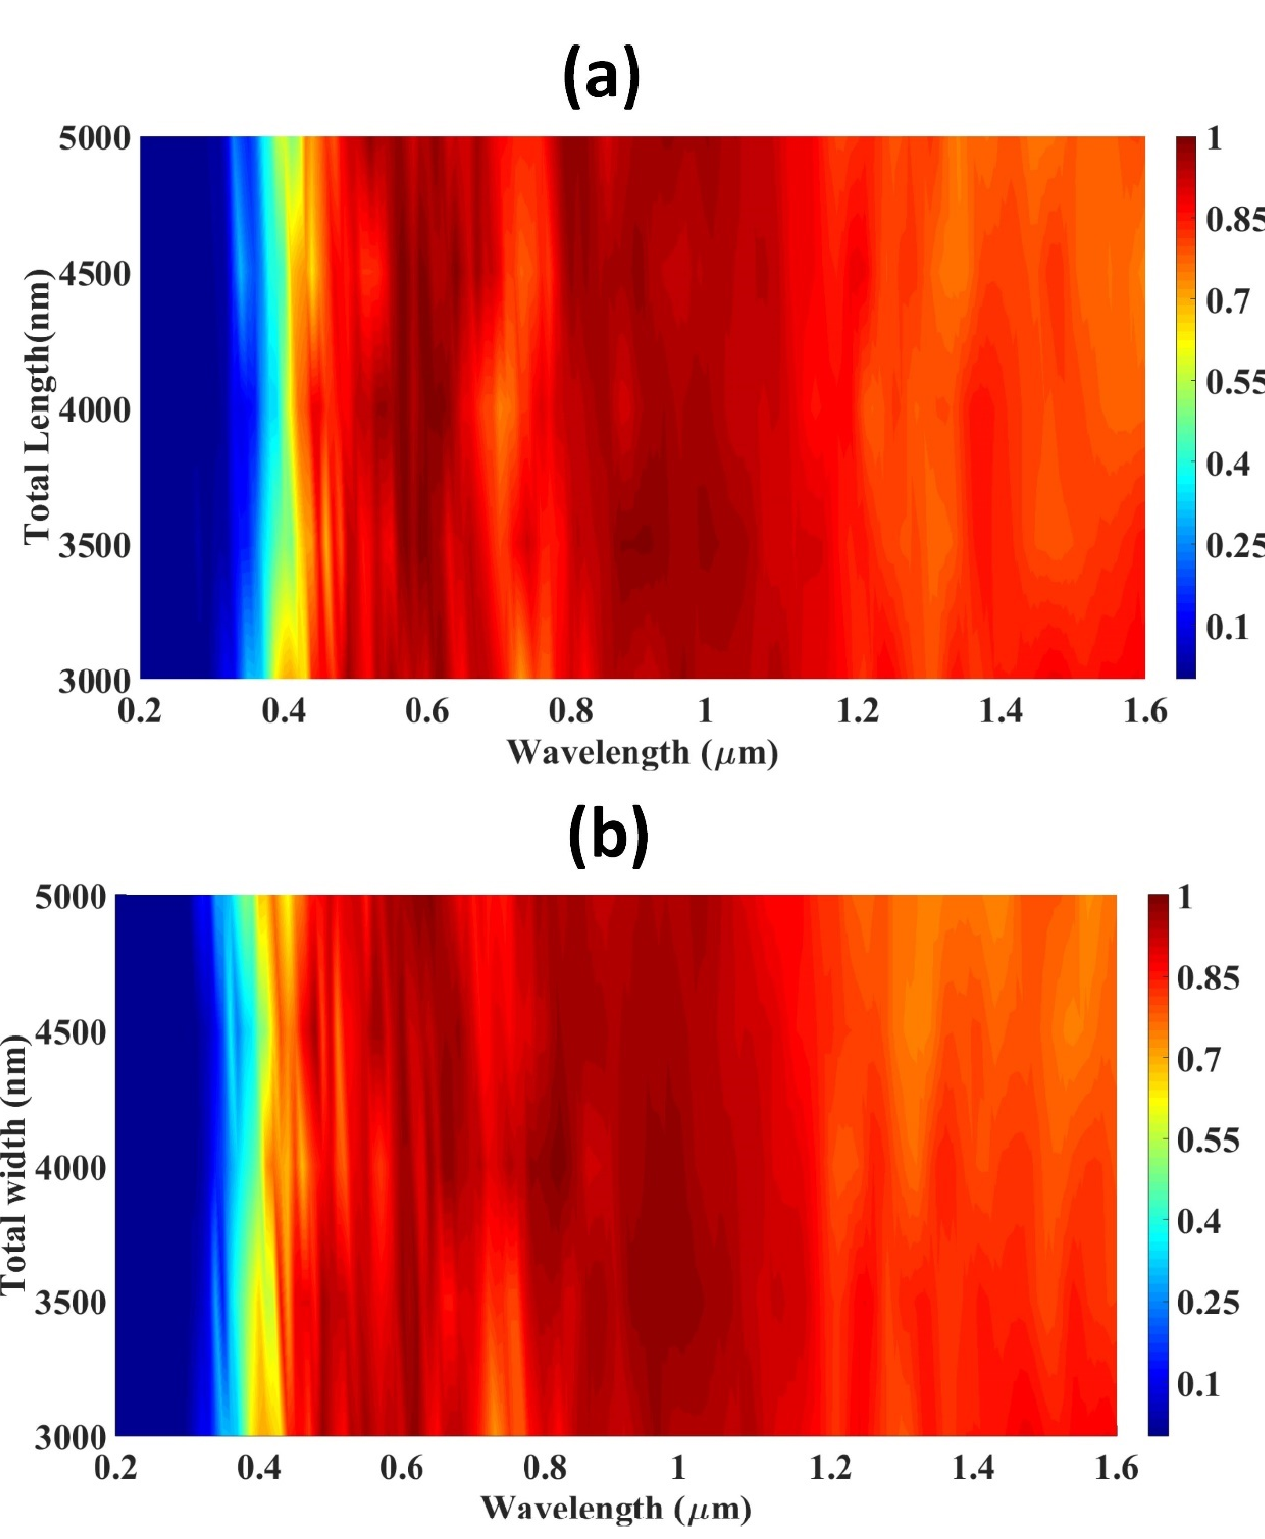
Figure 4. Parameter variation for the range of 0.2 to 1.6 micrometers. ( a ) Total length (nm). ( b ) Total width (nm). The increase in length and width of the substrate decreases the absorption. The optimized value of the total length and width of the substrate are 3000 nm